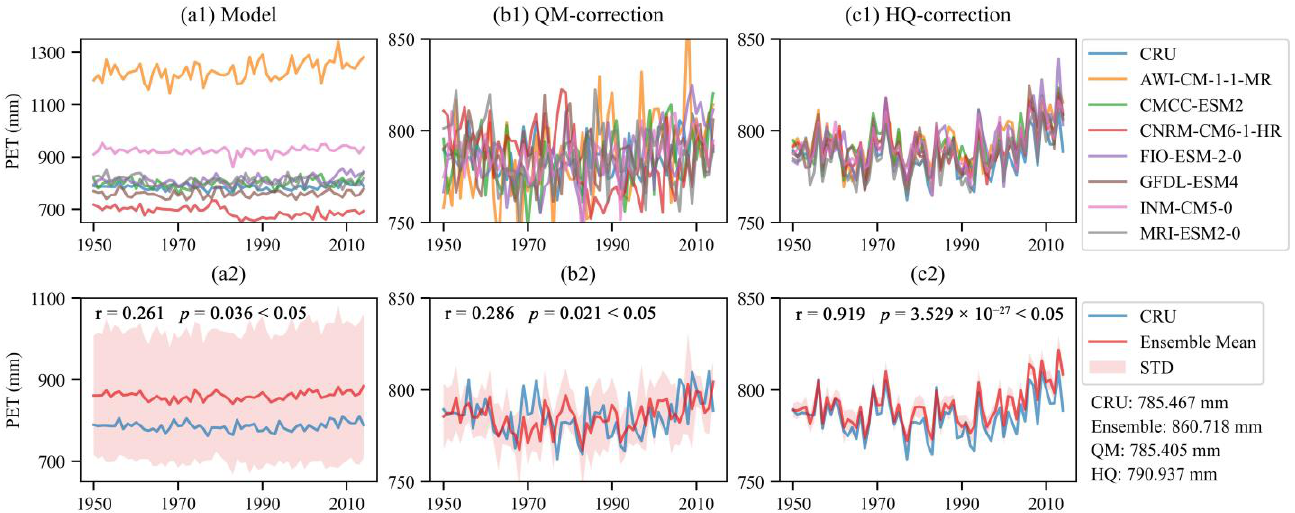
Figure 7. Spatial distribution and variation of annual mean PET before and after HQ correction. ( a – c ) are, respectively, the original, the HQ-corrected, and the variation between them. ( a1 – a4 ) are his- torical, SSP1-2.6, SSP2-4.5, and SSP5-8.5 scenarios, respectively. Then, we estimated three different forms of SPEI, including SPEI (uncorrected), SPEI (only TP corrected), and SPEI (TP and PET corrected) based on the run theory. Figure 8 depicts the feature of intensity, whereas Figures S3 – S6 depict the features of frequency, duration, and severity in historical and future scenarios. When compared to the future scenario, the average drought severity of a single occurrence in the historical scenario var- ies from 0.50 to 062, while it rises to 0.62~0.68 (Figure 8). Along with drought intensity, individual drought event duration and severity have also gotten longer and worse. We quantified the distinction between the three types of drought intensity, as shown in Figure 9, to more thoroughly investigate how drought intensity changed over the repair process. In Figures S7 – S10, the frequency, duration, and severity characteristics are displayed. The three different types, respectively, represent three meanings. Intensity ((TP-